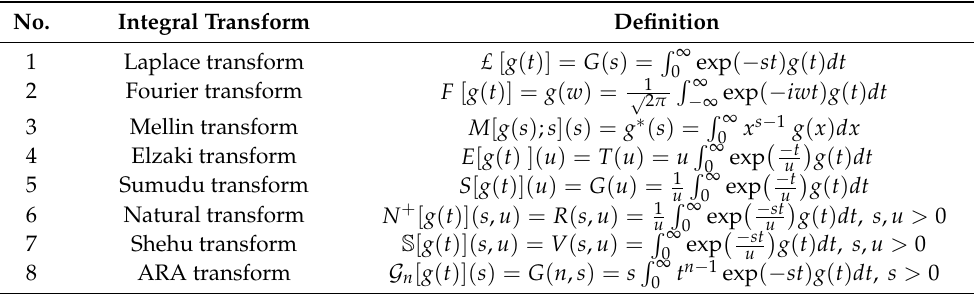
Table A4. Some integral